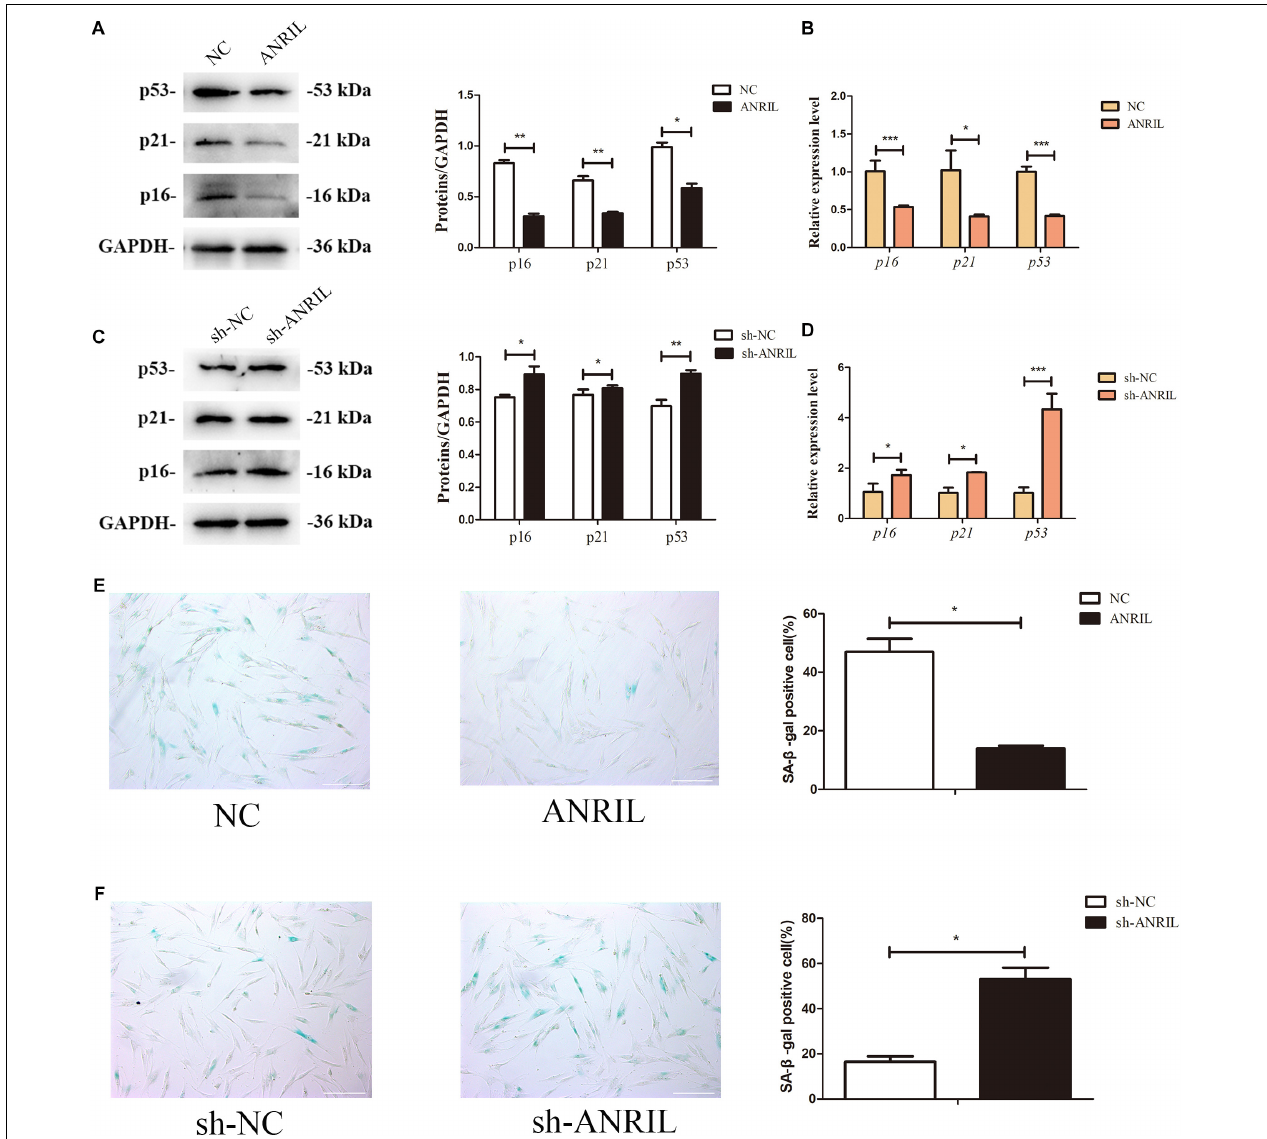
FIGURE 3 | LncRNA ANRIL affects the senescence of iPDLSCs. (A) Protein expression of p16, p21, and p53 in the ANRIL group and NC group. (B) mRNA levels of p16 , p21, and p53 in the ANRIL group and NC group. (C) Protein expression of p16, p21, and p53 in the sh-ANRIL group and sh-NC group. (D) mRNA levels of p16 , p21, and p53 in the sh-ANRIL group and sh-NC group. (E,F) SA- β -gal staining showed less senescent cells in the ANRIL group and less senescent cells in the sh-ANRIL group. Scale bar = 100 µ m (* P < 0.05, ** P < 0.01, *** P <